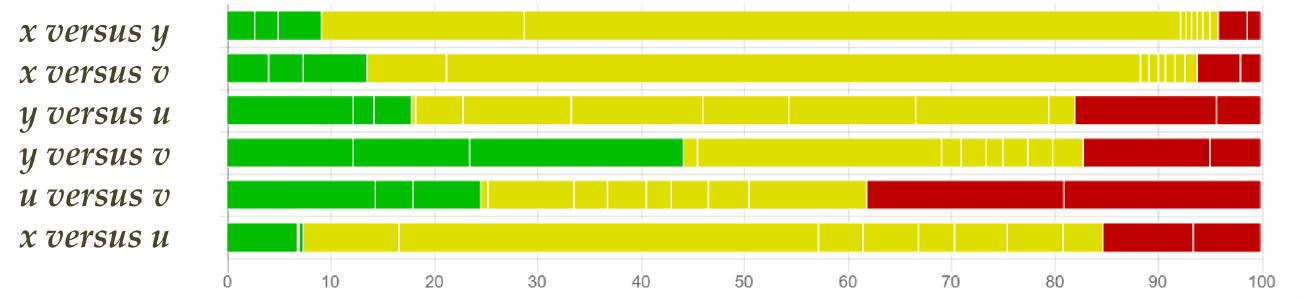
Figure 3. Bar plot showing the study proportion contributions of direct comparisons with low (green), moderate (yellow) and high (red) risk of bias. The bar plot has been produced in CINeMA (Confidence In Network Meta-Analysis) software 11 . Studies are synthesized using the random effects model. x , no treatment; y , quinolone antibiotic; u , non-quinolone antibiotic; v , antiseptic.